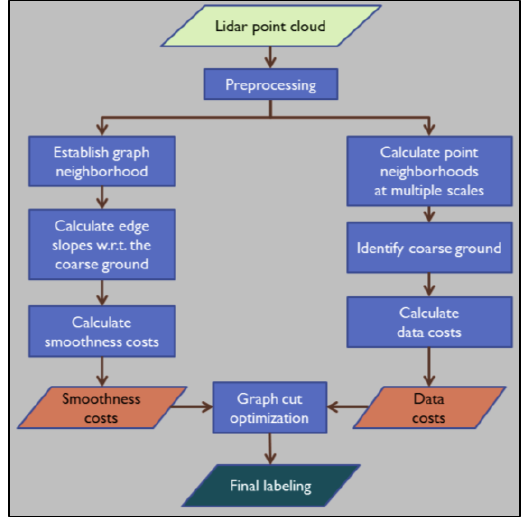
Figure 5. Workflow for min-cut ground filtering of airborne lidar data.